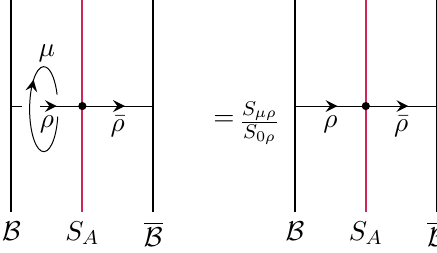
Figure 8. Action of the line (cid:11) +